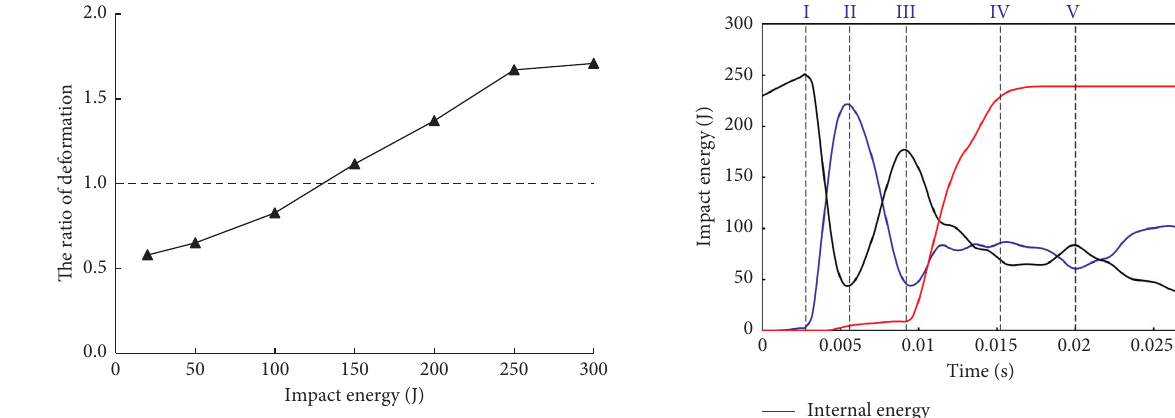
Figure 14: The ratio of the maximum rebound deformation and the maximum compression deformation versus impact energy.